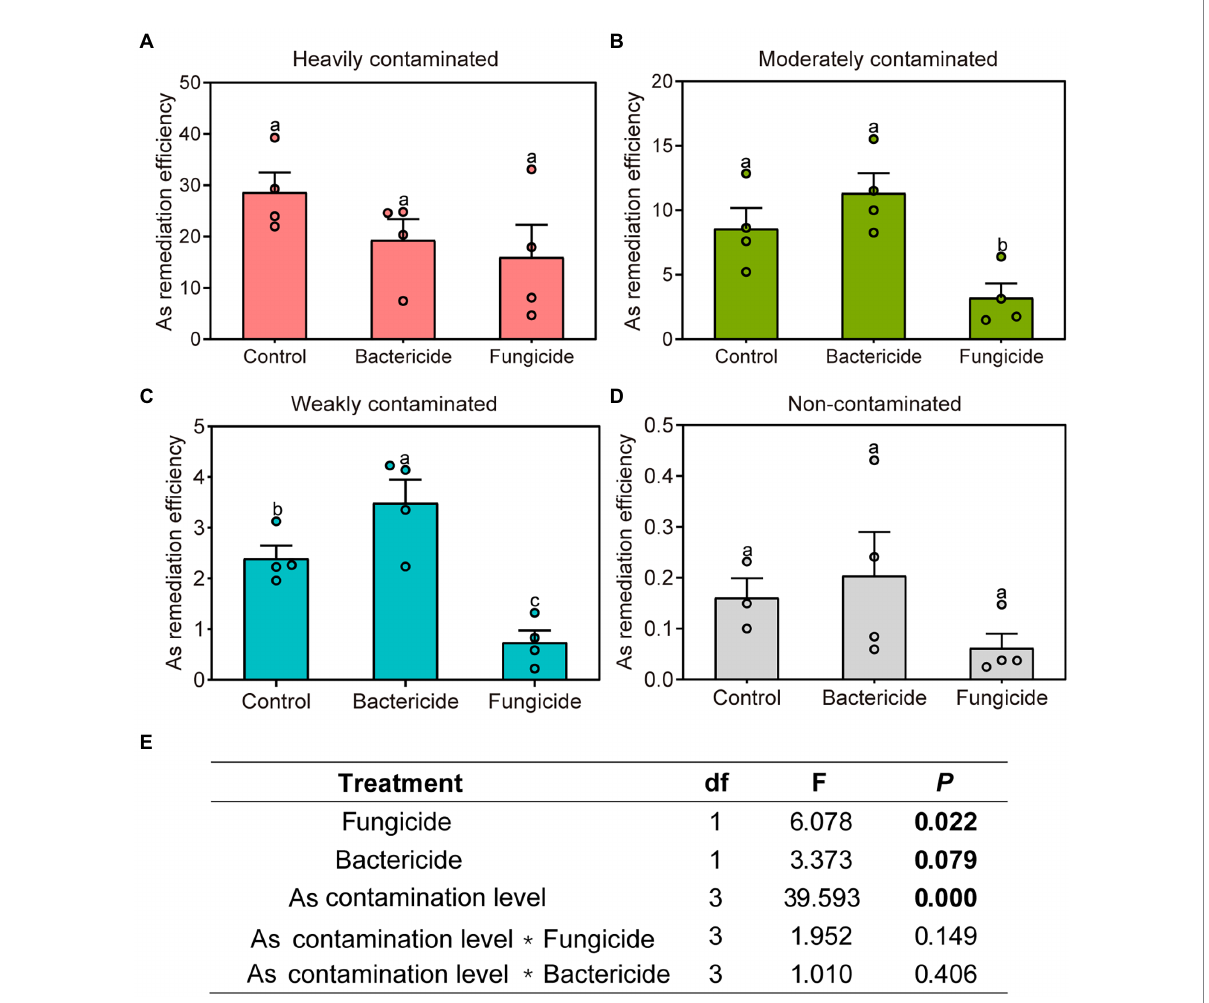
FIGURE 7 Effects of bactericide or fungicide application on the remediation efficiency of Pteris vittata grown in sites with different levels of arsenic contamination reflected by (A–D) Duncan multiple comparison and (E) analysis of variance. Different lowercase letters on bar plots denote significant differences between treatments (Duncan multiple comparison, p <